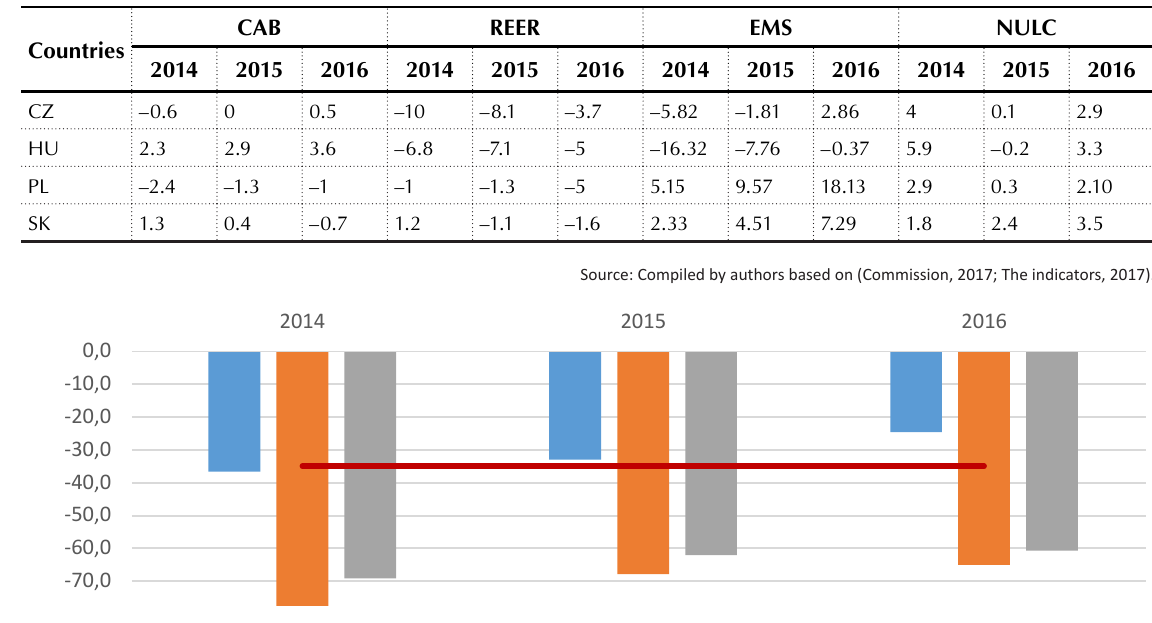
Table 4. The external indicator of MIP (excluding NIIP) of the Visegrad Group in 2014–2016